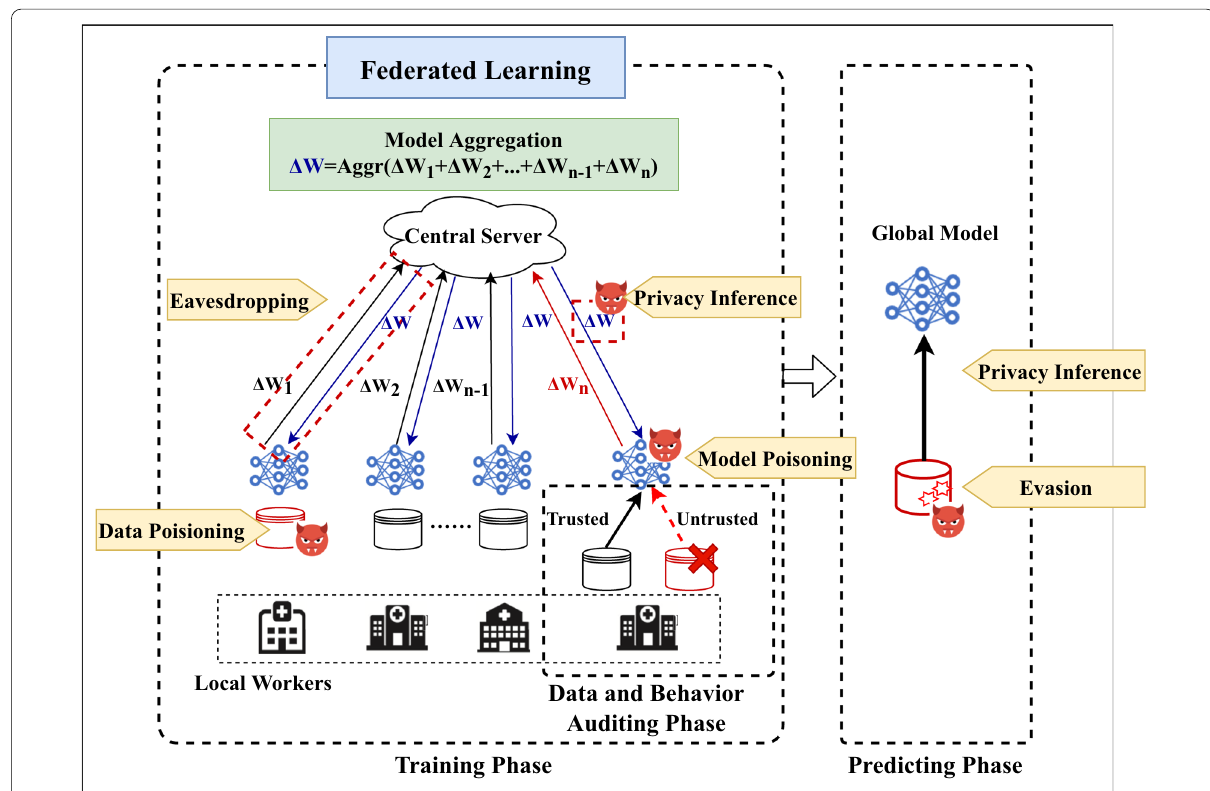
Fig. 1 The multi-phases framework of FL including data and behavior auditing, model training and model